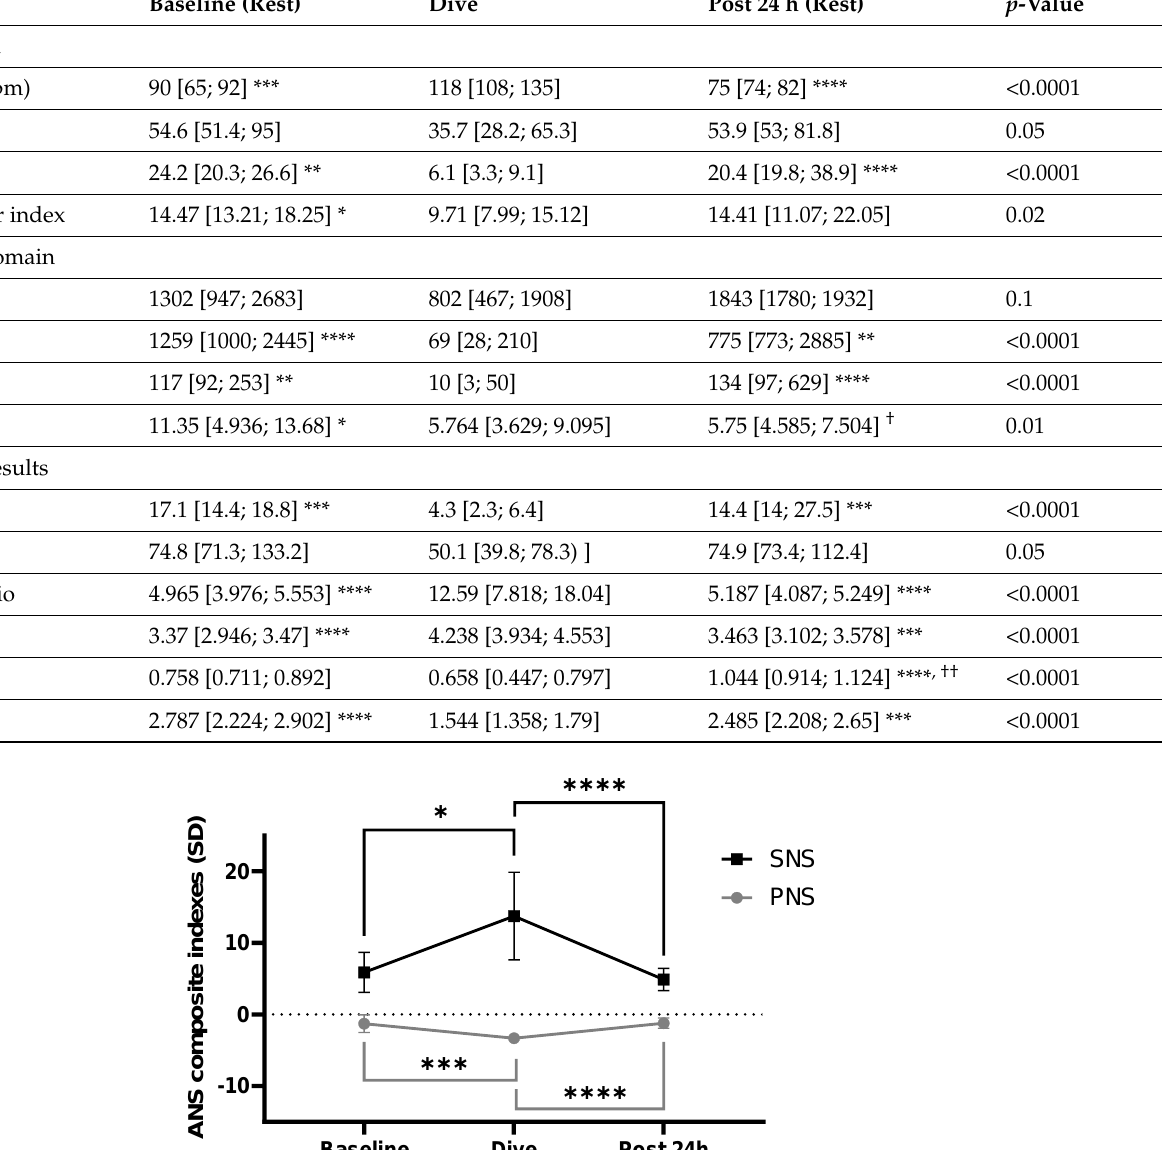
Figure 4. Autonomic nervous system (ANS) composite index measured by HRV. HRV parameters were performed at rest, in sitting position at baseline and 24 h after last day dive. Dive measurements were recorded in immersion during the diving program ( n = 23). PNS, in parasympathetic nervous system; SNS, sympathetic nervous system; SD, standard deviation of measurement to the normal population average. Dunn’s multiple comparisons test is expressed versus dive with * p < 0.05, *** p < 0.001 and **** p <